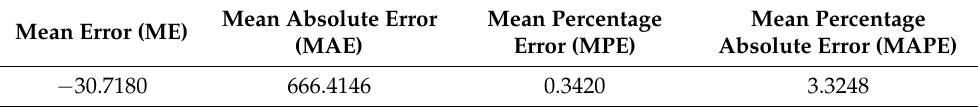
Table 4. Forecast errors. Source: own